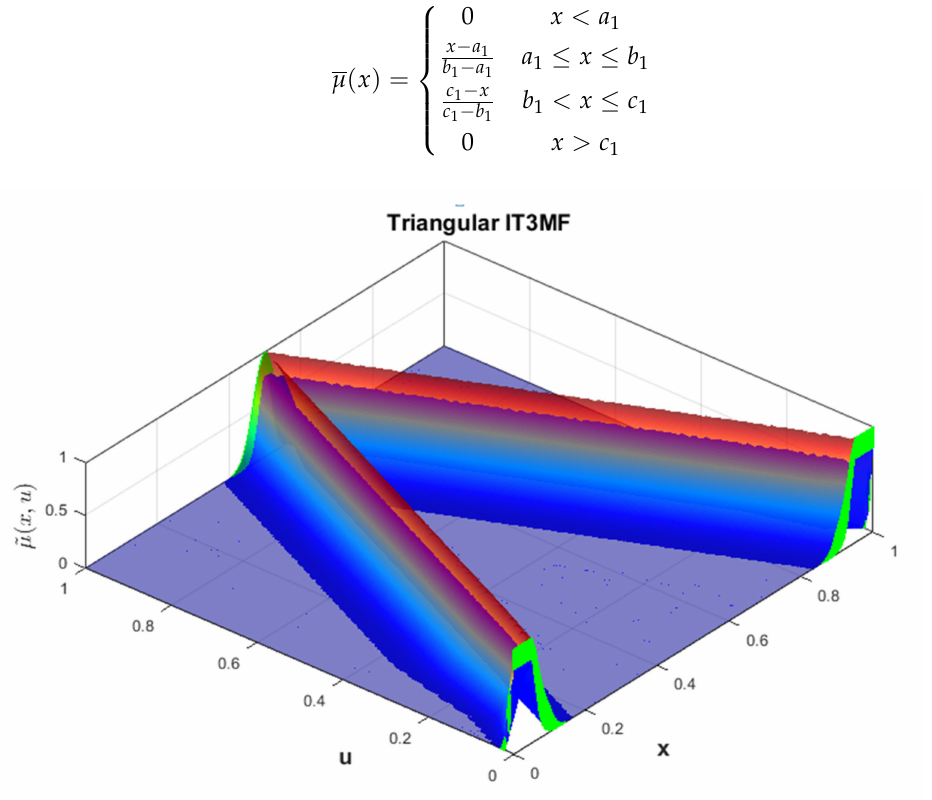
Figure 10. Visual representation of the ScaleTriScaleGaussIT3MF